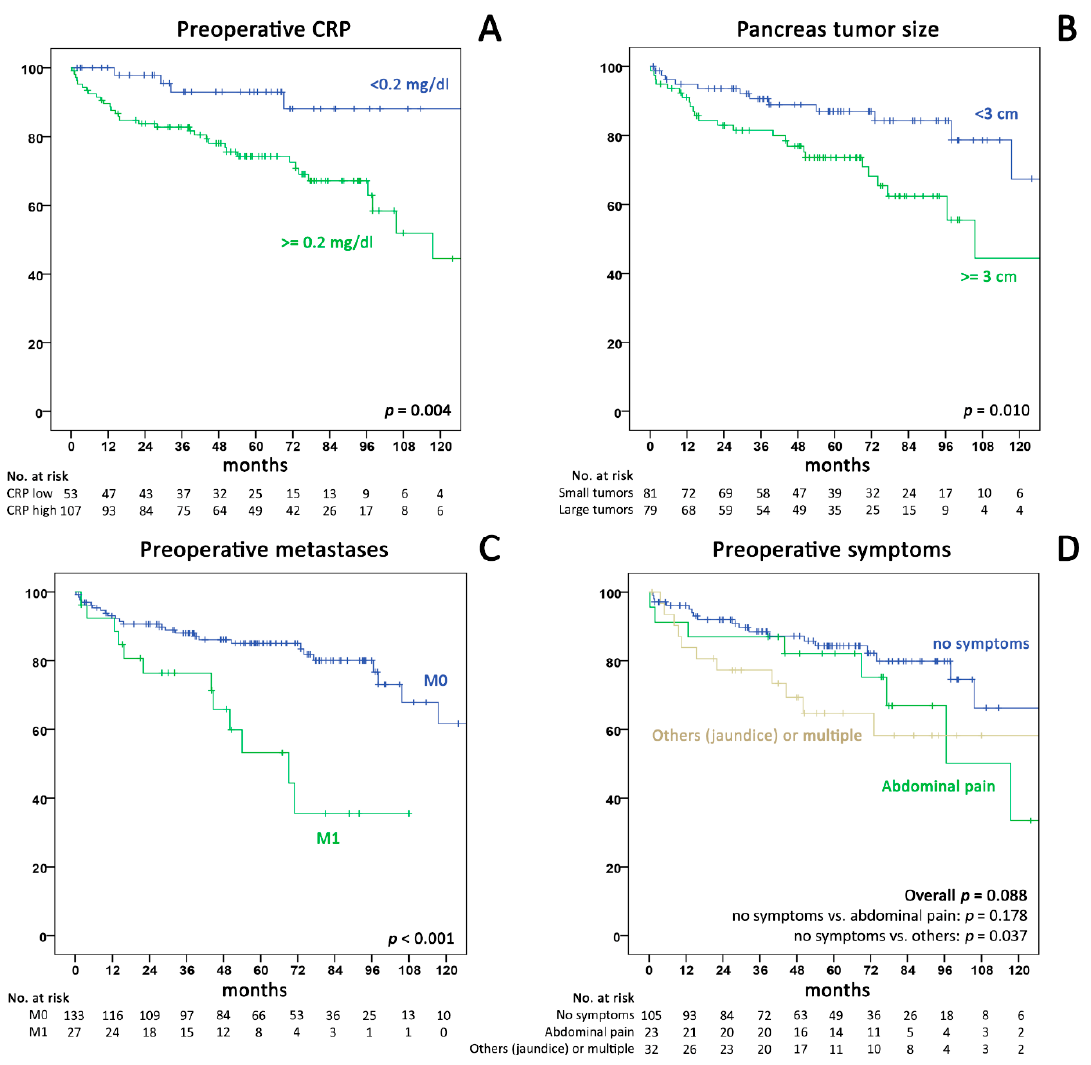
Figure 2. Kaplan–Meier curves for overall survival in the national ASSO cohort stratified by ( A ) preoperative CRP (cut-o ff 0.2 mg / dL; p = 0.004), ( B ) tumor size (cut-o ff 3 cm; p = 0.010), ( C ) metastases ( p < 0.001), ( D ) symptoms (no symptoms versus pain p = 0.178; no symptoms versus other / multiple symptoms p = 0.037). CRP = C-reactive protein.